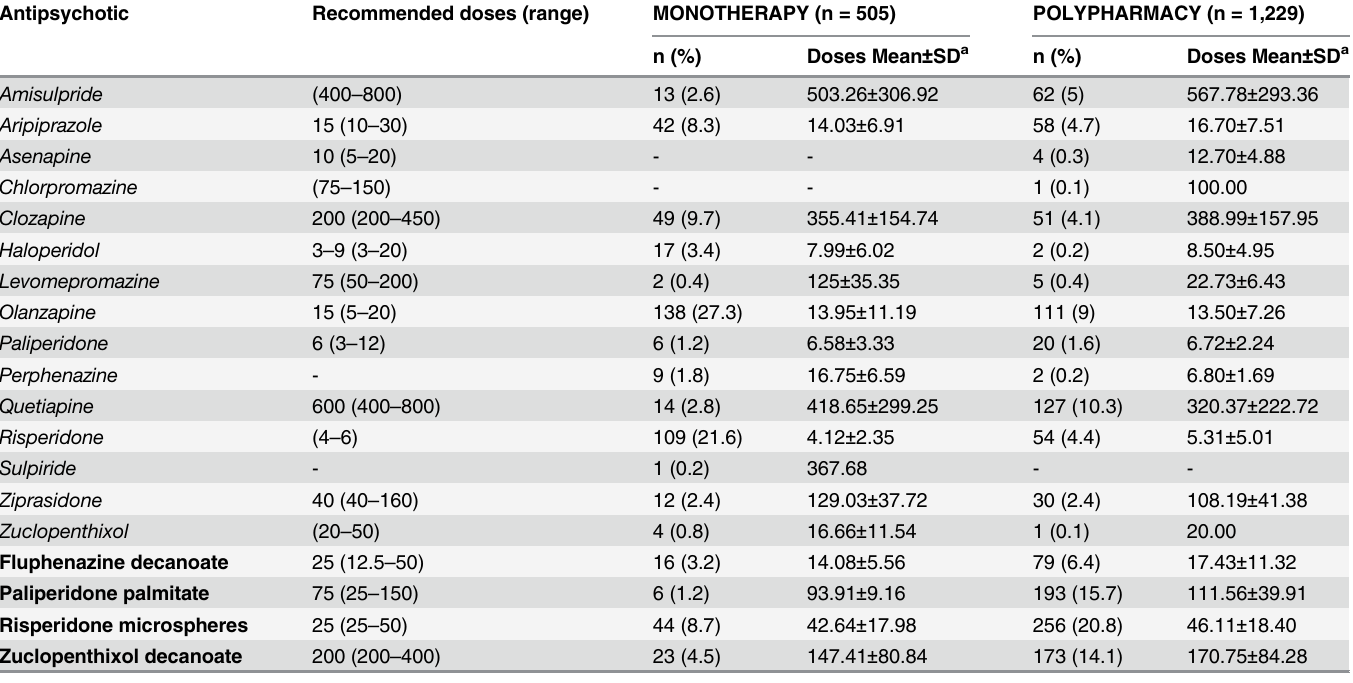
Table 2. Antipsychotic prescription patterns for 1,734 of 1,765 outpatients with schizophrenia. Recommended maintenance doses and correspond- ing ranges according to the Spanish Medicines Agency are shown if available. Data are for principal antipsychotic treatments. Oral antipsychotics are in italic (n = 944) and LAI are in bold (n =